Question: Condense the content of this figure into a single sentence.
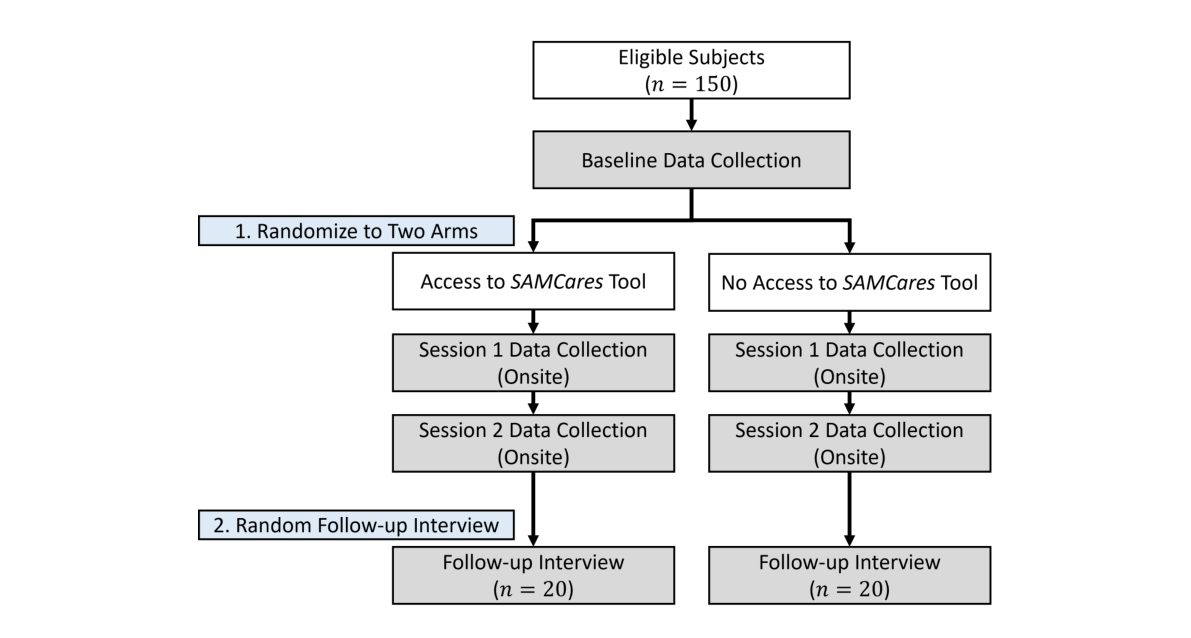
Answer: Schematic Representation of Randomization and Data Collection Process for SAMCares Tool Evaluation